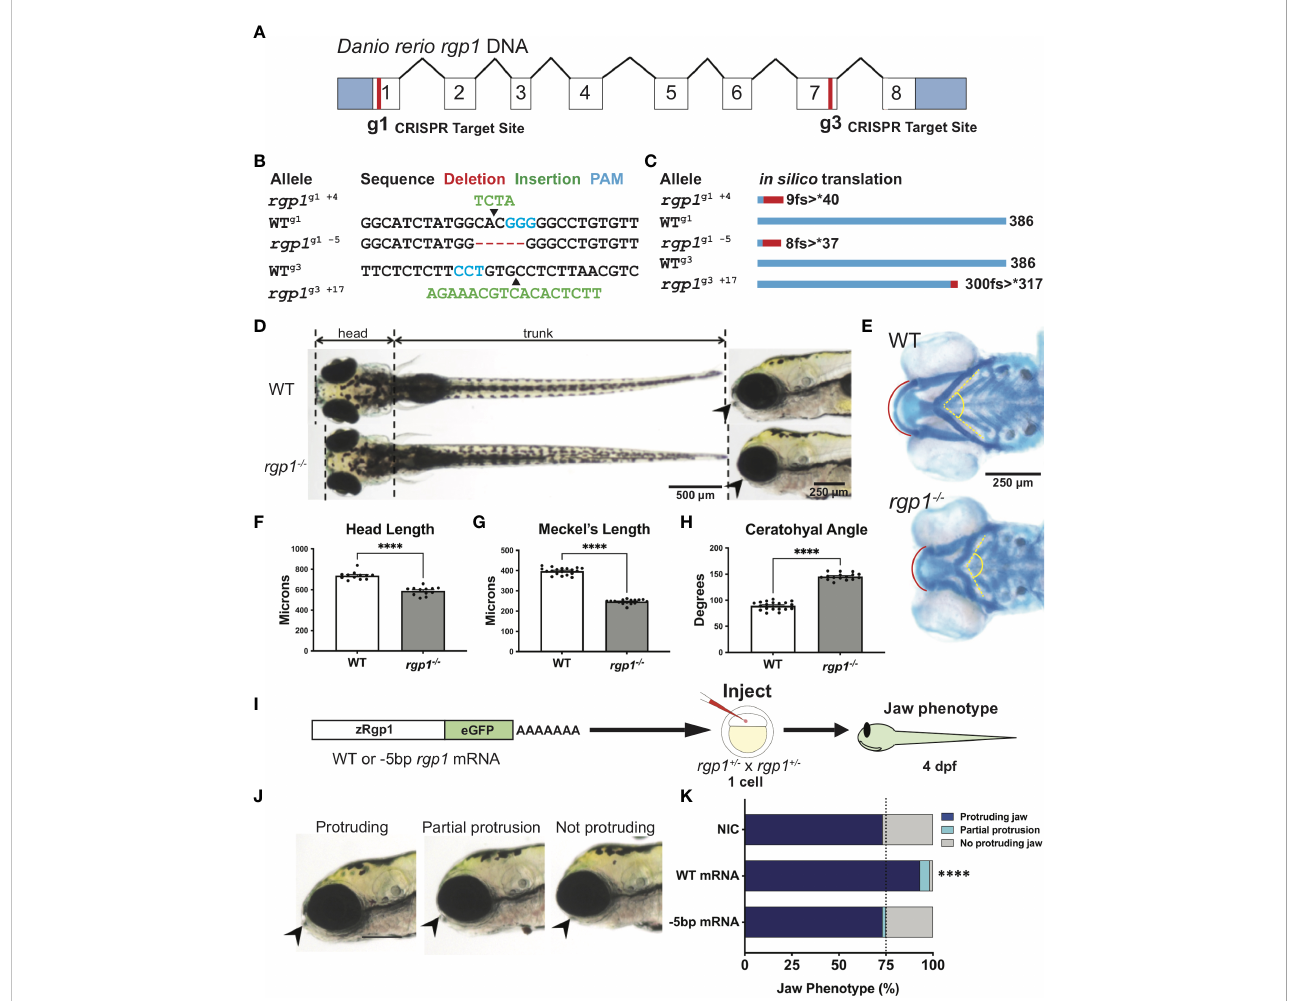
FIGURE 1 Rgp1 is required for zebra fi sh craniofacial skeletal development. (A) Zebra fi sh rgp1 intron/exon map showing locations of g1 and g3 gRNA target sites. (B) Sequences from three different alleles isolated from the use of g1 and g3 gRNAs. (C) Predicted peptide lengths for alleles shown in (B) . (D) Live imaging of 5 dpf WT and rgp1 -/- larvae from ventral and lateral view showing jaw protrusions (black arrowhead). (E) Alcian blue staining and imaging of 5 dpf WT and rgp1 -/- cartilage in the ventral craniofacial head skeleton. The Meckel ’ s cartilage (red), and ceratohyal (yellow, dashed) are marked. (F) Quanti fi cation of larva head length. (G) Quanti fi cation of Meckel ’ s cartilage length. (H) Quanti fi cation of ceratohyal cartilage angle. (I) Schematic for zebra fi sh rgp1 mRNA injection and rescue experiment. (J) Lateral images of larvae showing jaw protrusion, partial protrusion, and no protrusion phenotypes (black arrowheads). (K) Quanti fi cation of jaw phenotype percentages in groups of injected and non-injected embryos. Signi fi cance is presented by